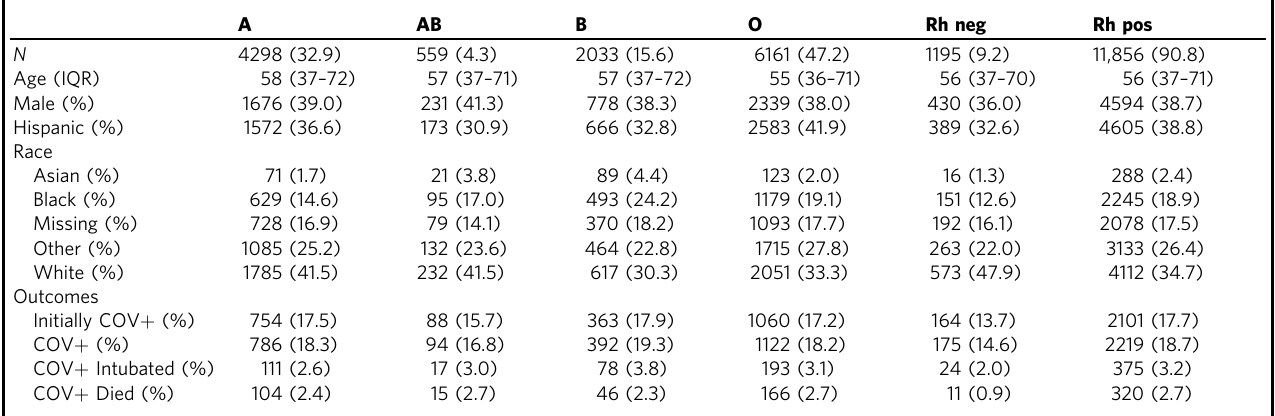
Table 1 Summary demographics for SARS-CoV-2-tested individuals at NYP/CUIMC, strati fi ed by blood